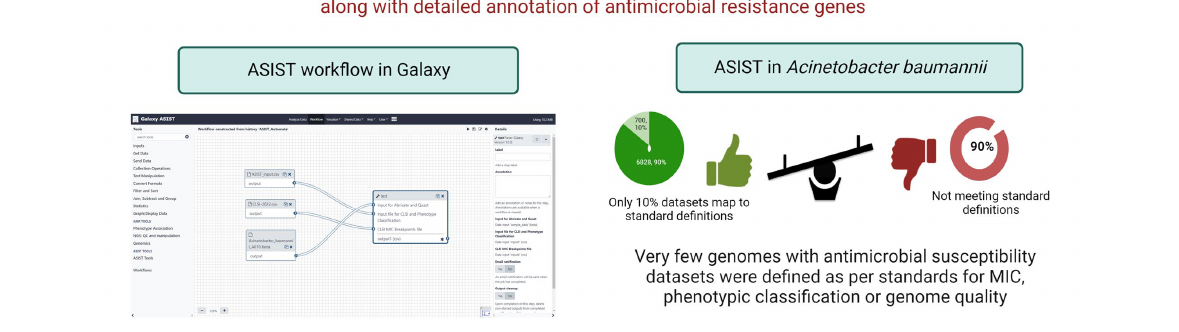
FIGURE 6 Galaxy-ASIST workflow. The existing modules along with the workflow interface are